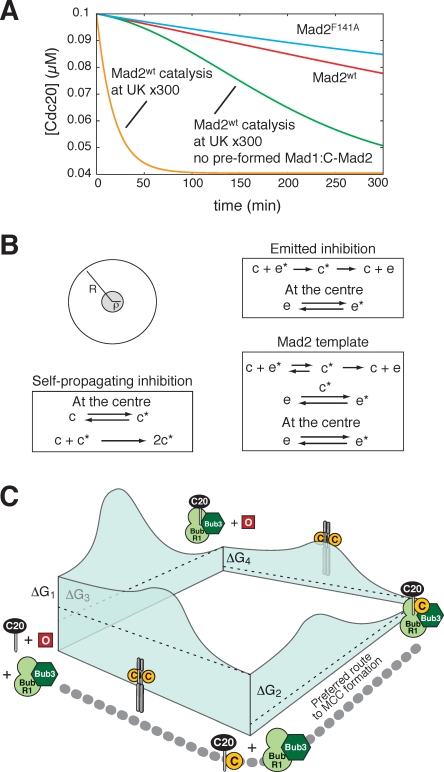
Models of Checkpoint Activation in Living Cells(A) In the presence of physiological concentrations of Mad2, Mad1:C-Mad2, and Cdc20, the full model of Figure 1D (reactions 1 to 5) starts with all Cdc20 and O-Mad2 in the free form. The timing and levels of Cdc20 sequestration in a Cdc20:C-Mad2 complex are plotted. The Mad2F141A mutant (blue line) sequesters Cdc20 extremely slowly. Mad2wt is faster, but still too slow to account for the rapid SAC activation observed in living cells. Only if we arbitrarily assume catalysis at the unattached kinetochores (i.e., at Mad1:C-Mad2) to be 300 times faster in vivo than in vitro (orange line), the activation timing is satisfactory. Only in the presence of preformed Mad1:C-Mad2 can the unattached kinetochores effectively reduce the SAC activation timing. If the Mad1:C-Mad2 complex had to form from Mad1 and O-Mad2, the initial SAC response would be slow even when the catalytic activity of kinetochores (green line) is increased 300 times. Thus, Mad1:C-Mad2 must exist at the beginning of SAC activation for the Cdc20:C-Mad2 complex to accumulate rapidly. Parameters are listed in Table 1, equations in Tables S1 and S2.(B) Graphical representations—adapted from the work of Barkai and collaborators [17]—of different SAC models. The small circle with radius ρ represents a kinetochore in a cell (circle with radius R) in which a given reaction (labelled “at the centre”) takes place. The self-propagating inhibition model and the emitted inhibition model were proposed by Barkai and collaborators [17], whereas the Mad2 template model [13] is described with a formalism similar to that adopted in [17]. Note that here, the only irreversible reaction is the reactivation of the inhibited form of the cell cycle progression protein c. The self-propagation model is distinct from the Mad2 template model. (See Discussion for more detailed descriptions of c, c*, e, and e*.)(C) A speculative representation of the energy profile of the formation of the MCC complex. ΔG1 to ΔG4 describe Gibbs' free energies for the four reactions described in the diagram. The first step of the preferred route to MCC formation is the formation of the Cdc20:C-Mad2 complex. The reaction is spontaneous, but the activation energy is extremely high. Conformational dimerization catalysed by Mad1:C-Mad2, and unknown additional factors can lower the activation energy, but the equilibrium of the reaction is unchanged. The formation of the MCC complex eventually takes place through the binding of Cdc20:C-Mad2 to a preformed BubR1:Bub3 complex. Red squares indicate O-Mad2; yellow circles indicate C-Mad2.